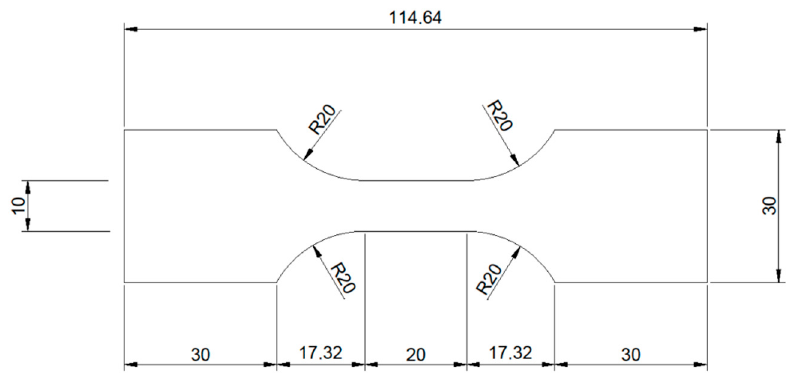
Figure 10. Shape and dimensions of the tensile testing